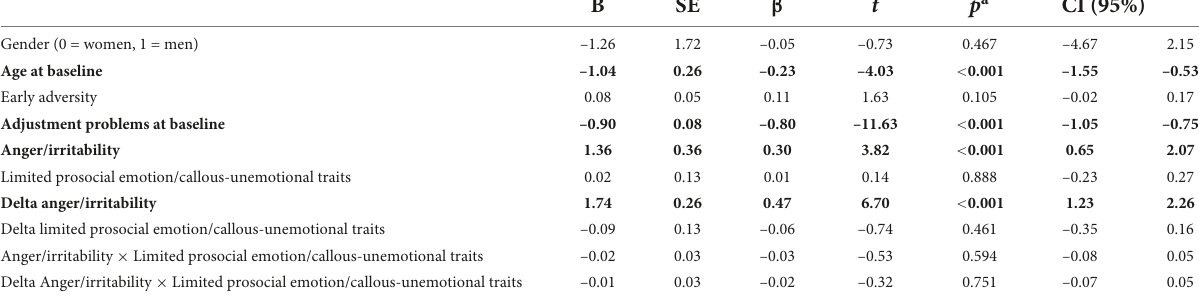
TABLE 7 Prediction of impairment of adjustment problems